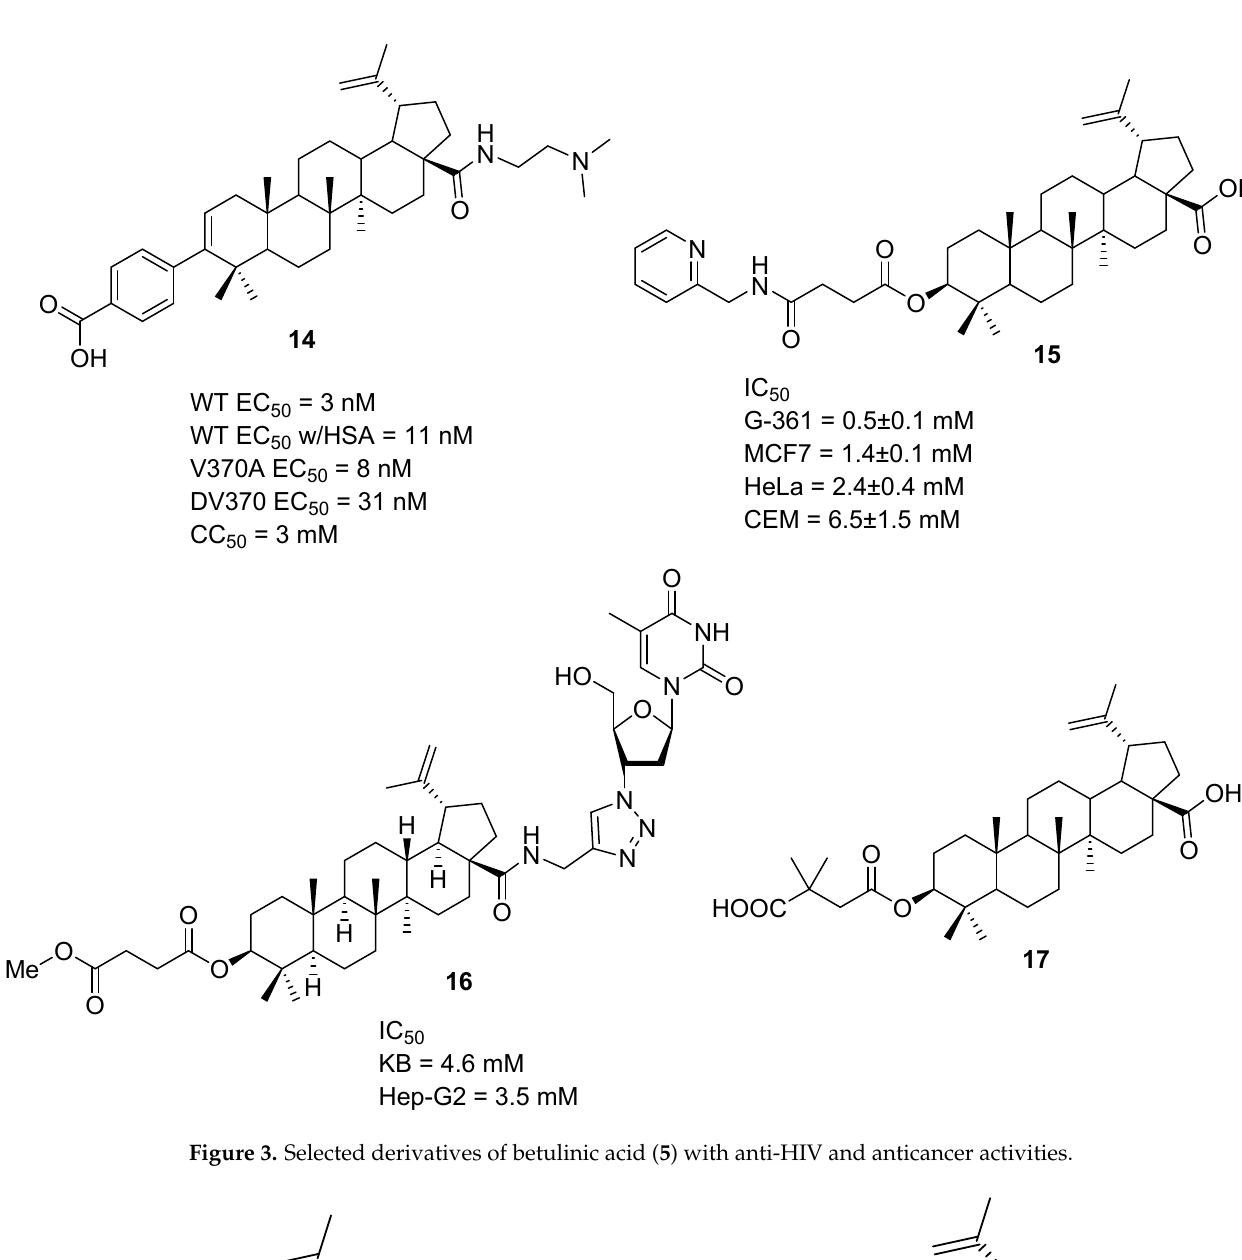
in 2016, Khan et al. [73,74] synthetized propargyl betulinate 18 using the conditions de-